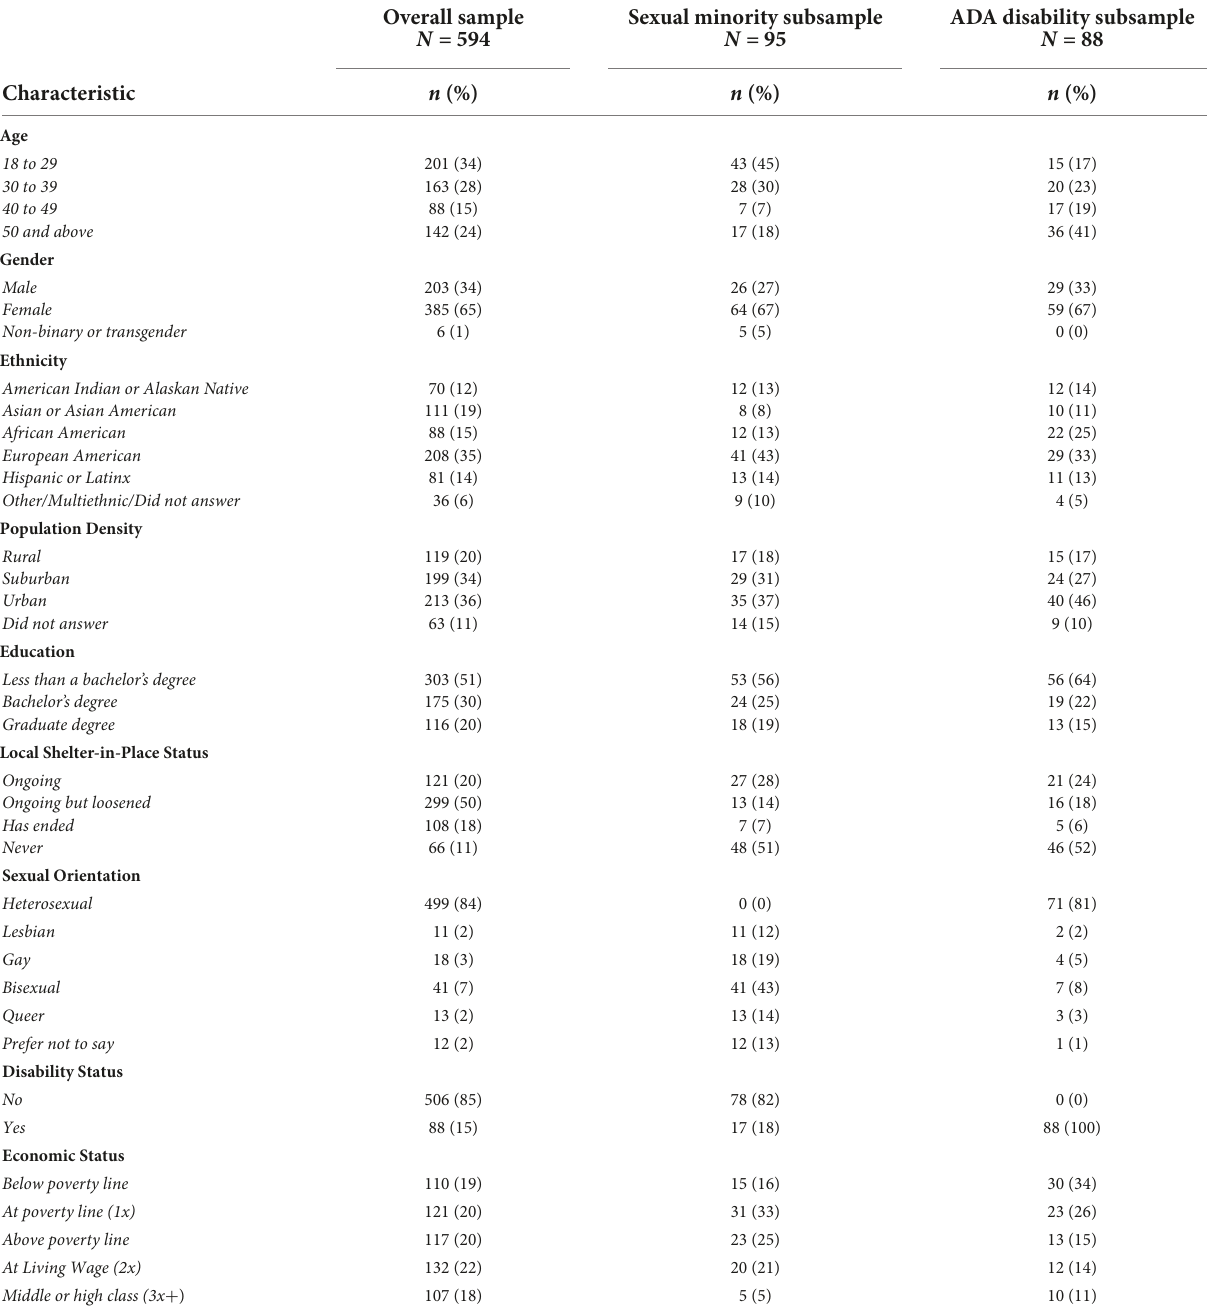
TABLE 1 Participant demographics and key